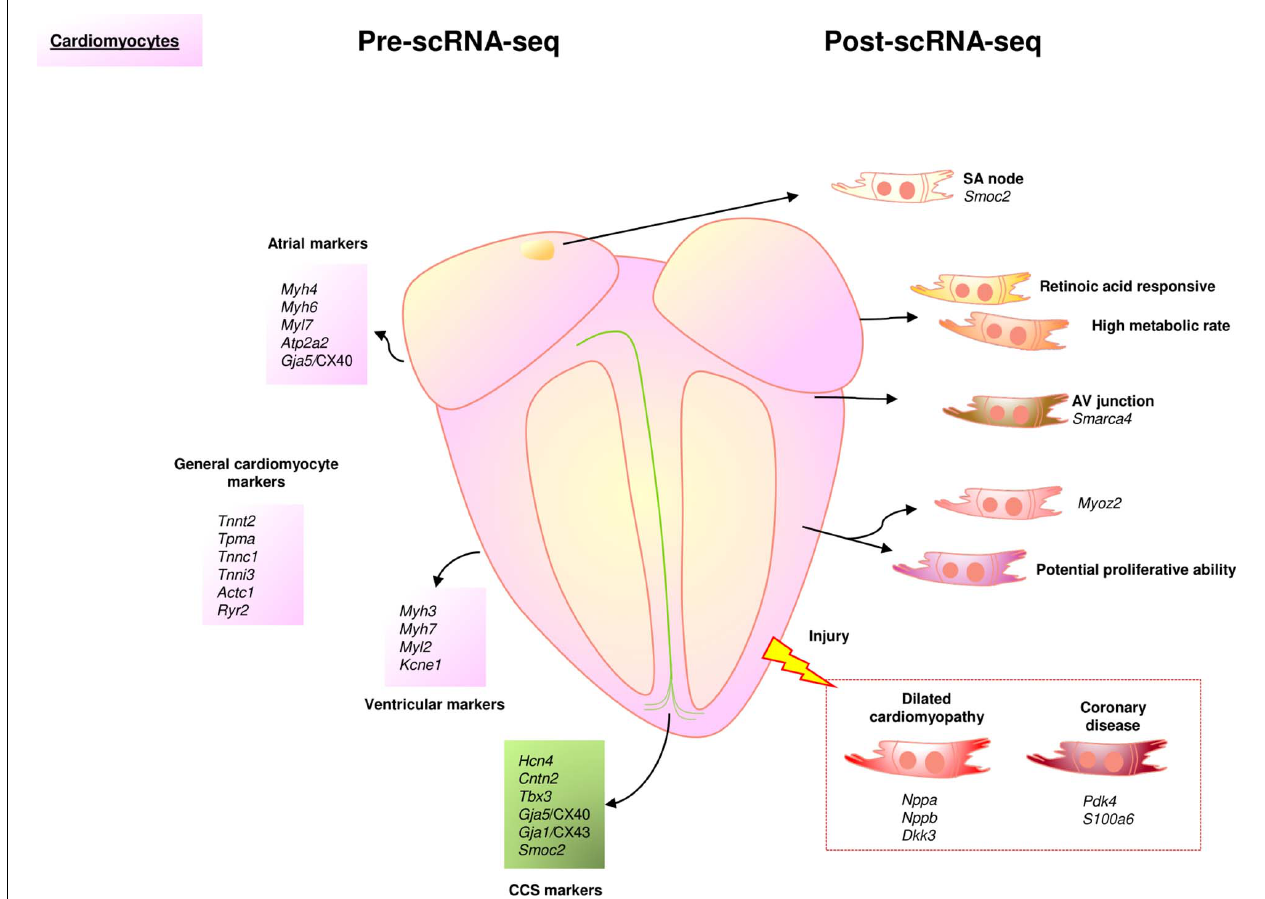
FIGURE 1 | Cardiomyocytes landscape before and after scRNA-Seq. In the scRNA-Seq part, each cell represents an identified cluster characterized by one or more genes, a specific cell function or other cell aspects. Nppa and Nppb gene expression identifies characteristic cardiomyocyte subpopulations in the pathological context of dilated cardiomyopathy. CCS, cardiac conduction system; SA, sinoatrial; AV,